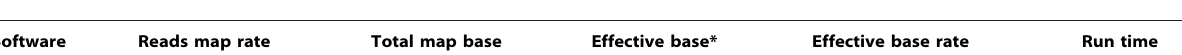
Software Reads map rate Total map base Effective base* Effective base rate Run time